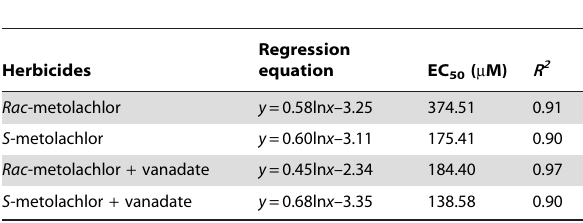
Table 1. Effects of various chemicals on the growth of maize shoots (4 d after